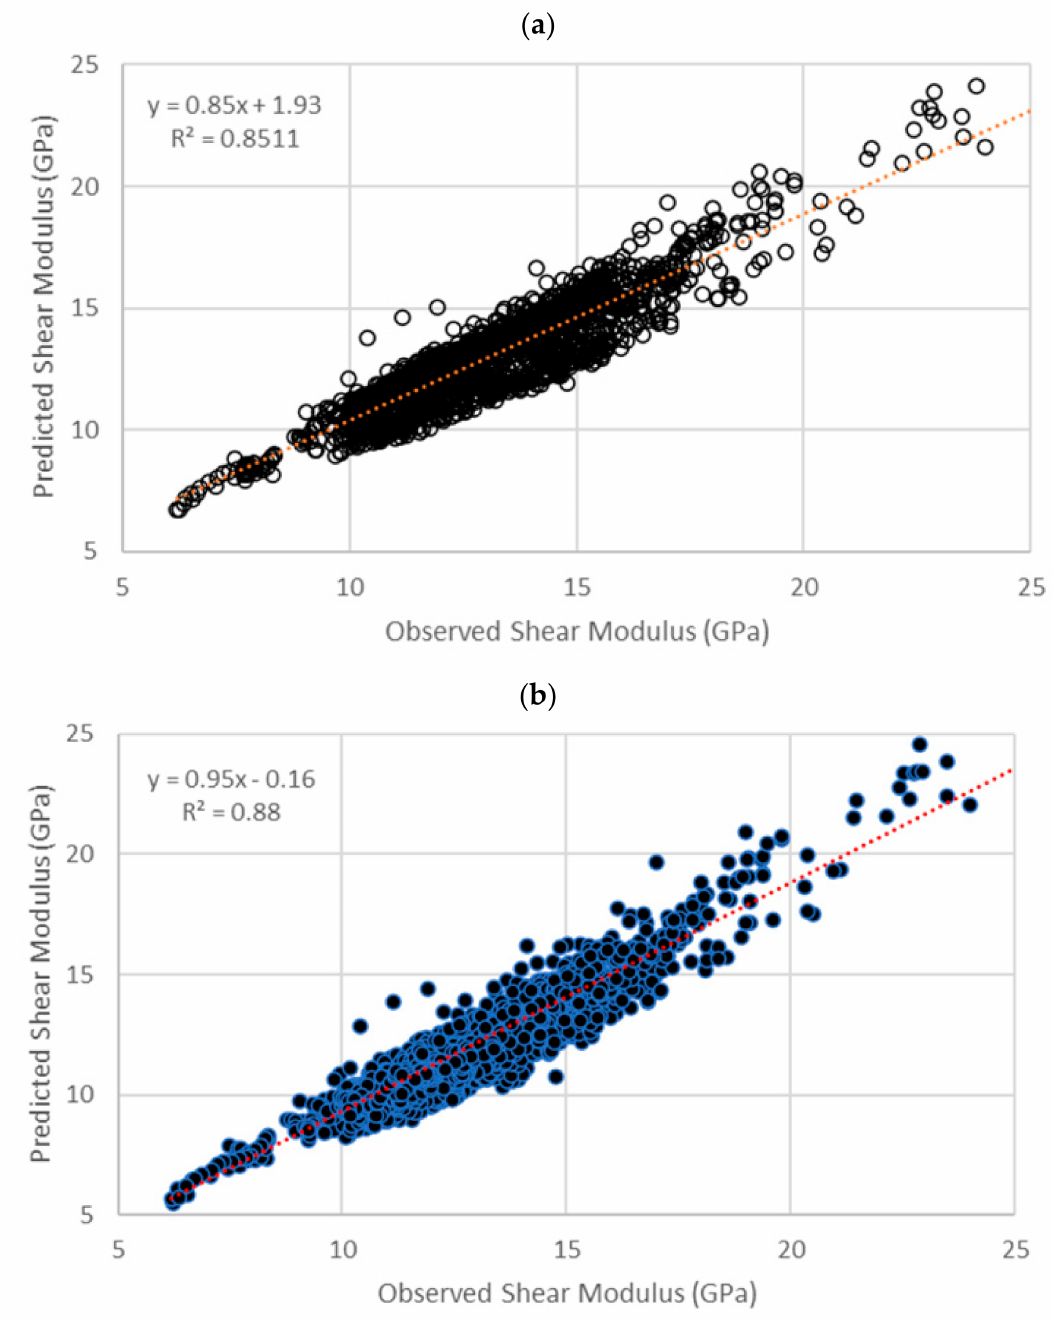
Figure 11. Predicted versus observed dynamic shear moduli. ( a ) using only P-wave modulus with Equation (7), and ( b ) using P-wave modulus, and fractional volumes of TOC, clay, and carbonate with Equation (8). The prediction using P-wave modulus and composition has a higher correlation, a smaller standard error, and is closer to the diagonal (exhibiting less bias for small and large